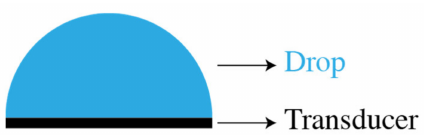
Figure 2. Simulated configuration for ultrasonic propagation in a drop.